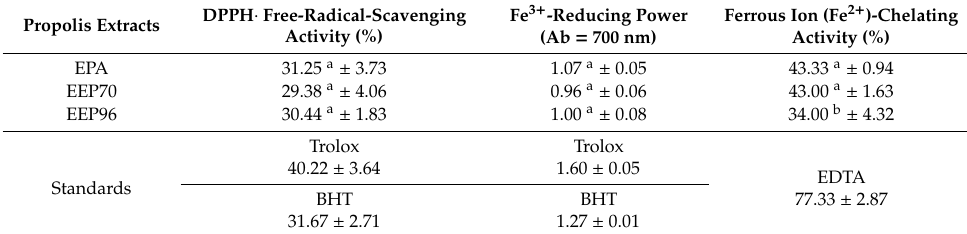
Table 3. The antioxidant activity of propolis extracts at the concentration of 0.1 mg / mL.